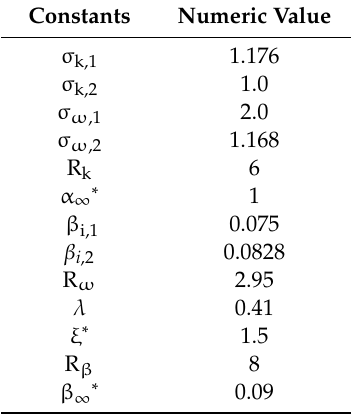
Table 3. Turbulence model constants k- ω SST (shear-stress